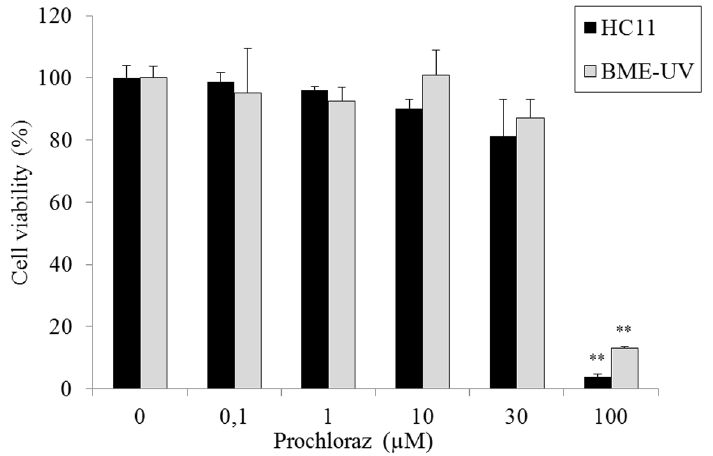
Fig 4. Cell viability in HC11 and BME-UV cells treated with prochloraz for 24h. The data represent means ± SD; n = 6. Statistically significant differences as compared to vehicle controls * p (cid:1) 0.01. Experiment repeated twice and data shown from one representative